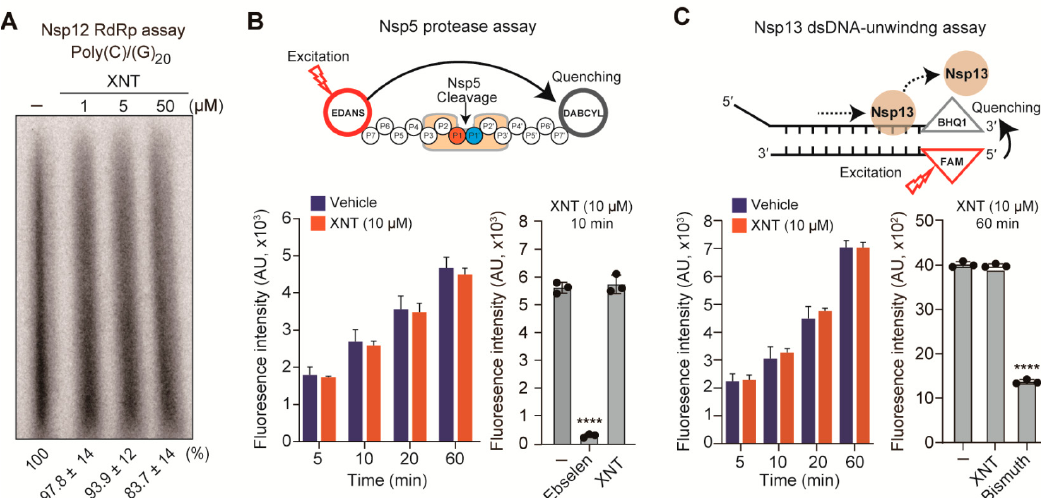
Figure 6. Analysis of inhibitory activity of XNT on SCoV2 enzymes. ( A ) SCoV2 Nsp12 (RdRp) inhibitory activity of XNT, evaluated by an in vitro RdRp assay with a poly(C) template in the presence of the oligo(rG) 20 primer. Shown below are representative phosphorimager image from three independent experiments, which are signal intensities of radioisotope-labeled RNA products (mean ± SD from three independent experiments). ( − ), DMSO (4%) vehicle only-treated. ( B ) Schematic illustration of an in vitro FRET-based SCoV2 Nsp5 protease assay (top). Inhibitory activity of XNT and ebselen (10 µ M each), determined by measuring fluorescence intensity of the cleaved peptide substrate bearing DABCYL (quencher) and EDANS (donor), for up to 60 min (bottom left) or for 10 min (bottom right). ( C ) Schematic illustration of the FRET-based SCoV2 Nsp13 helicase assay (top). Inhibitory activity of XNT and bismuth citrate (10 µ M each), determined by measuring fluorescence signals emitted from the 5 (cid:48) FAM of the single-strand DNA separated from the DNA duplex substrate with 5 (cid:48) d(T) 20 overhang and 3 (cid:48) BHQ1 quencher, for up to 60 min (bottom left) or for 60 min (bottom right). Vehicle in ( B , C ), 1% DMSO (final concentration) in a reaction buffer. **** p <0.0001; by unpaired two-tailed Student’s t -test.